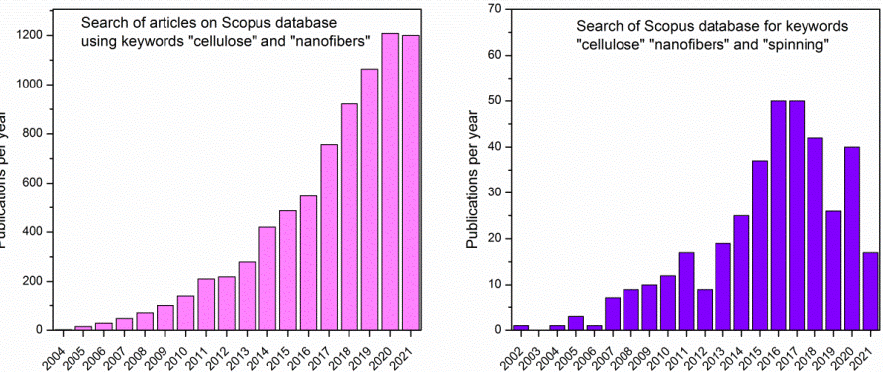
Figure 1. Number of publications per year from database Scopus using keywords “cellulose” and “nanofibers” ( left ) and refined search including the word “spinning” ( right ).